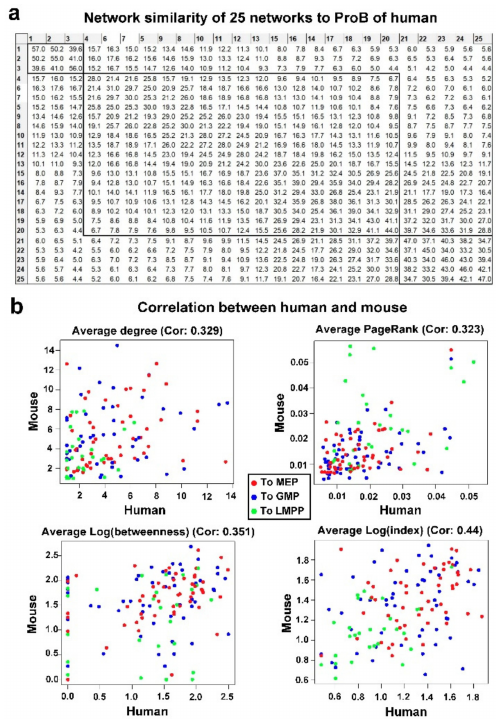
Figure 4. ( a ) Network similarity of 25 networks of human. Values in grids are a sum of CNSI of all genes between two networks. The time points were ordered by hierarchical clustering. ( b ) Correlation of gene connectivity, PageRank, betweenness, and h-index between mouse and human. The Pearson correlations are significant with p values of degree: 0.00011, PageRank: 0.00015, Betweenness: 3.355 × 10 − 5 , h-index: 1.505 × 10 − 7